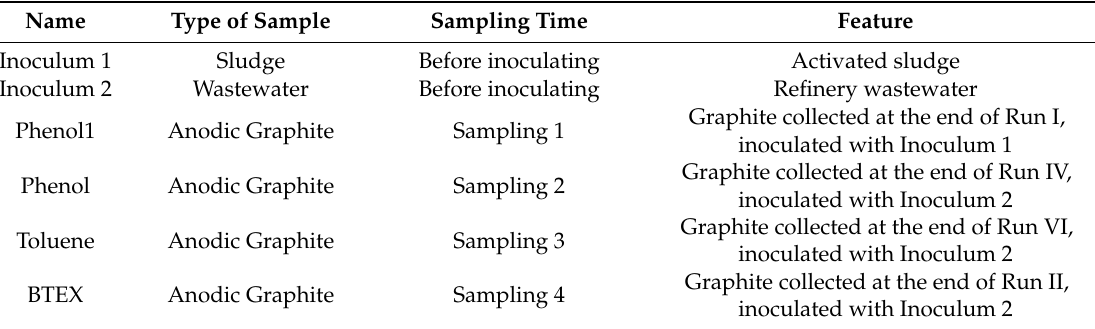
Table 2. Sample names and